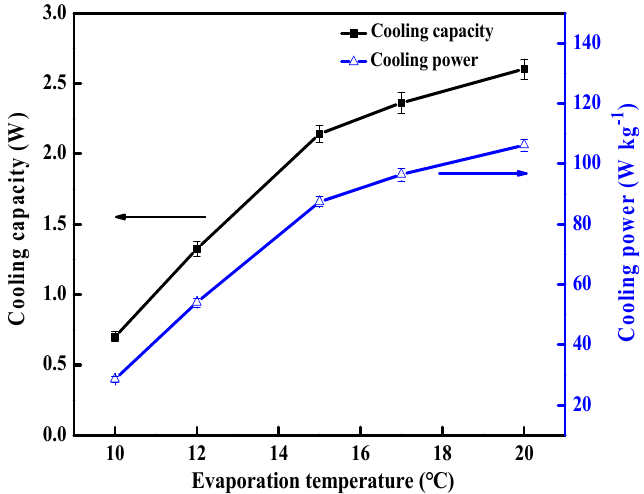
Figure 8. Cooling capacity and cooling power of an MIL-101/20%FLG-water working pair at different evaporation temperatures.